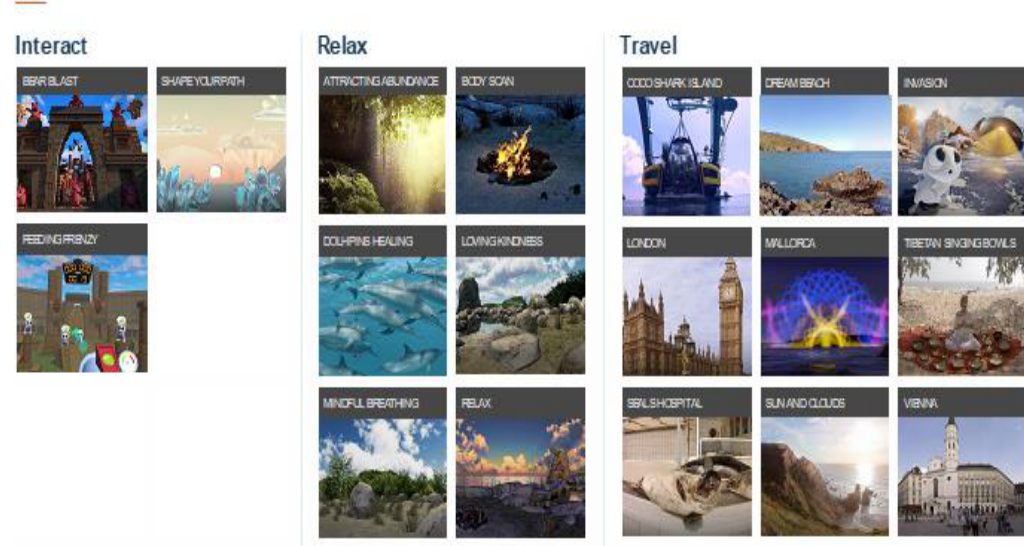
Figure 2. Example patient view using the AppliedVR software.